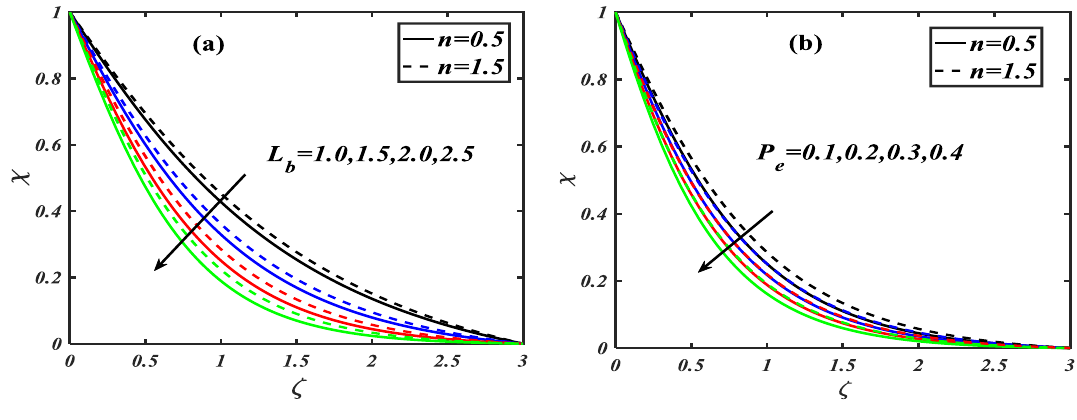
Figure 10. ( a ) Depicts the effect of L b while ( b ) depicts P e on χ(ζ)